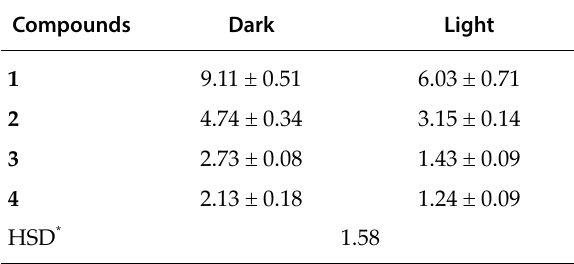
Table 1. Comparison of slopes from linear associations between necrotic areas on tissues of test plants and con- centrations of assayed compounds under dark and light conditions (slopes ± standard